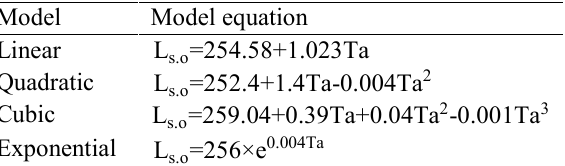
Table 3. Regression coefficients of fitted models